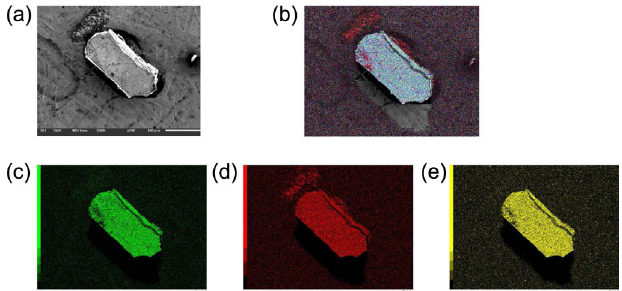
FIG. 6. Distributions of Lu, Pd, and Bi elements. (a) Scanning electron microscopy (SEM) image of the crystal that is irradiated to 3.13 and then to the 5 . 28 C = cm 2 dose, taken after the penetration depth measurements. (b) Overlay of EDX analysis of Lu (green), Pd (red), and Bi (yellow) distributions on the SEM image. (c) – (e) Distribution of each (c) Lu, (d) Pd, and (e) Bi